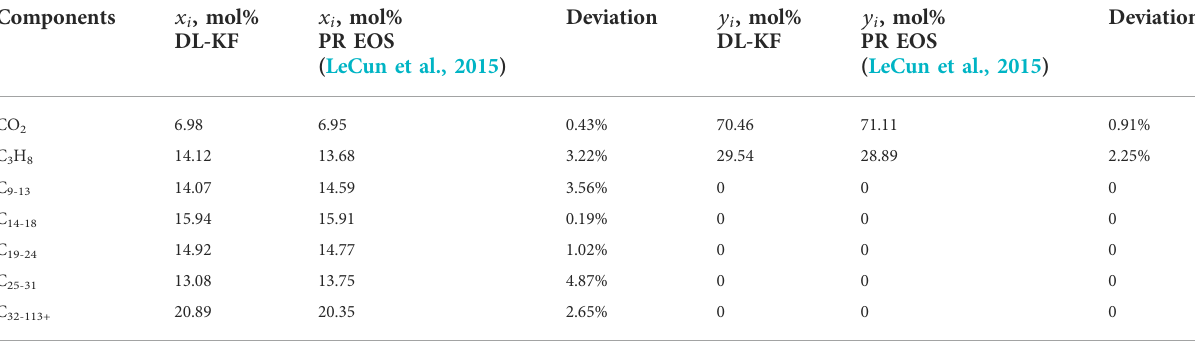
TABLE 8 The comparison results of components concentrations between the DL-KF modeling and PR EOS modeling. Components